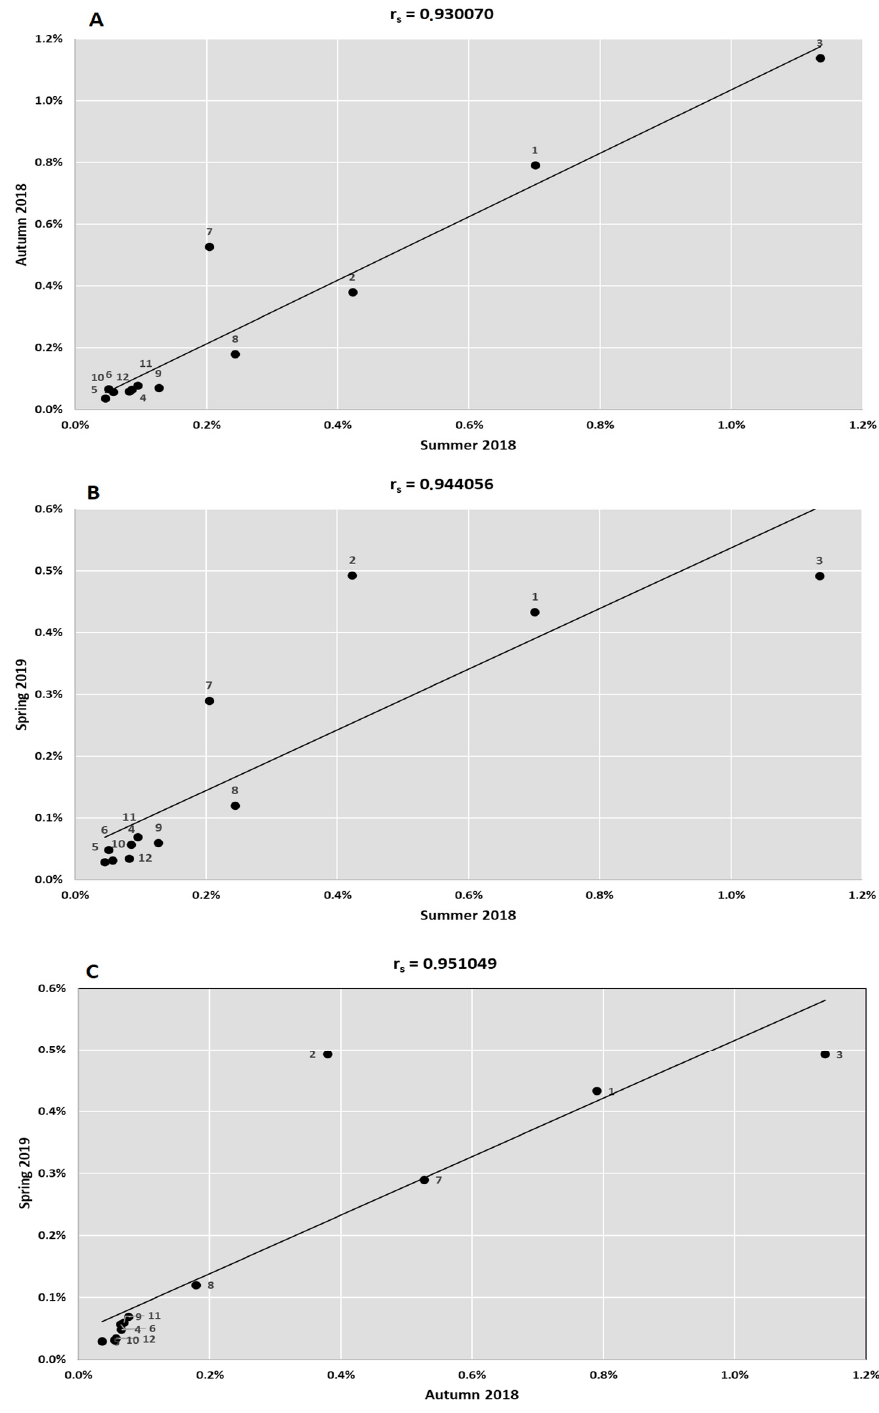
Figure 5. The Spearman’s rank-order correlation coefficient between the bacterial pathogens from the WHO list, occurring in various seasons ( p < 0.01). 1— Acinetobacter baumannii ; 2 —Pseudomonas aeruginosa ; 3— Enterobacteriaceae ; 4 —Enterococcus faecium ; 5 —Staphylococcus aureus ; 6 —Helicobacter pylori ; 7 —Campylobacter spp . ; 8— Salmonella spp . ; 9 —Neisseria gonorrhoeae ; 10 —Streptococcus